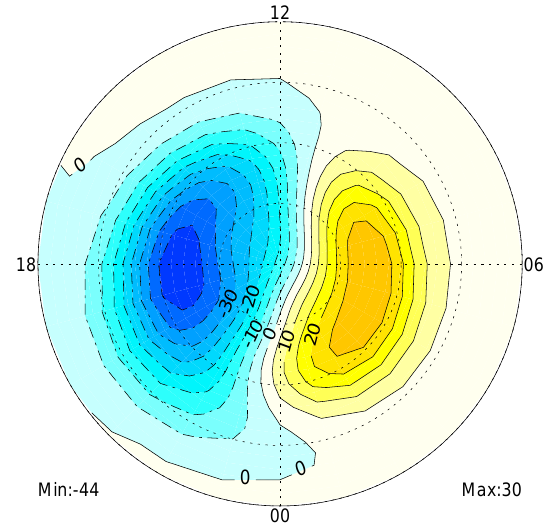
Plate 11. Ionospheric potential patterns from the Weimer (1996) model for equinox conditions during the same period as in Plate